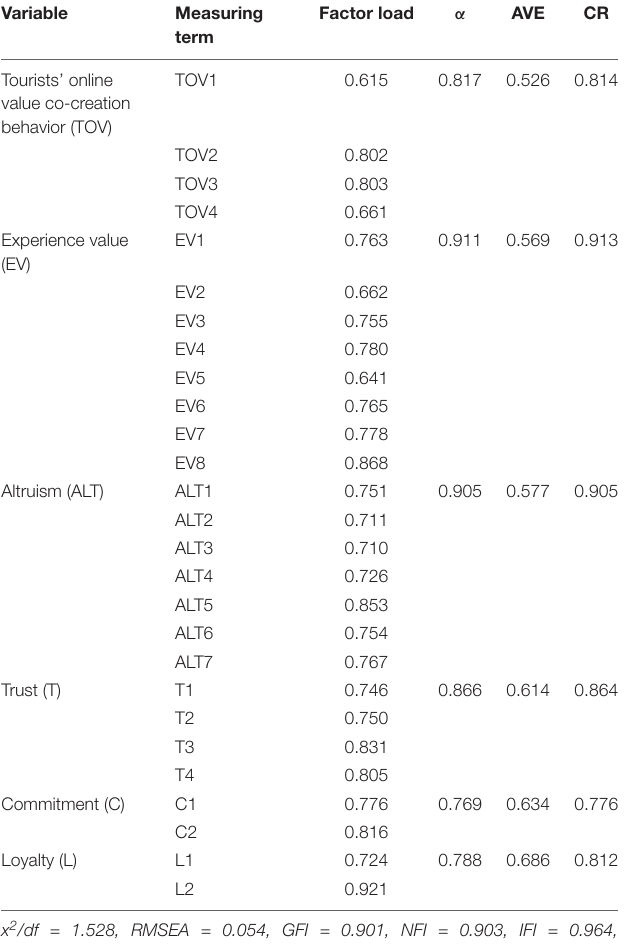
TABLE 3 | Reliability and validity test.